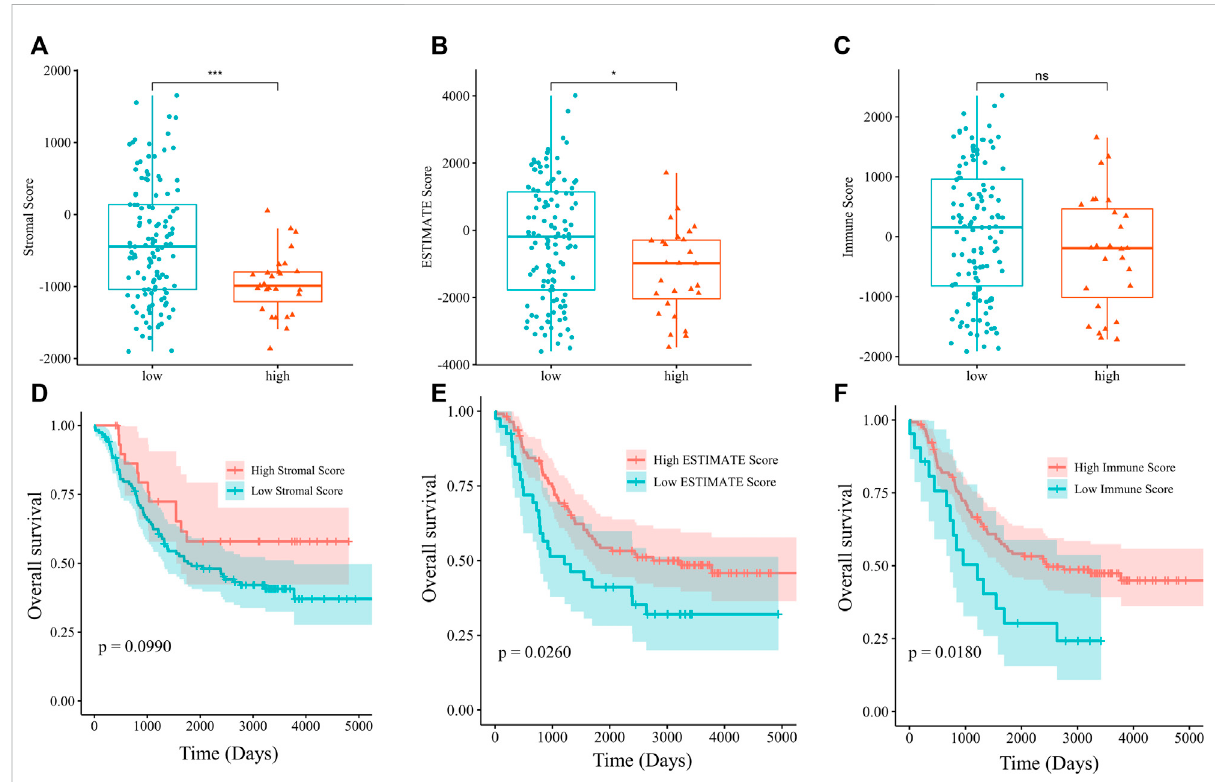
FIGURE 4 The analysis of relationship between the stromal (A) , ESTIMATE (B) , and immune score (C) and PSPH expression level. OS was evaluated by Kaplan-Meier method with log-rank test in NB patients grouped by the stromal (D) , ESTIMATE (E) , immune score (F) . * p < 0.05, *** p <